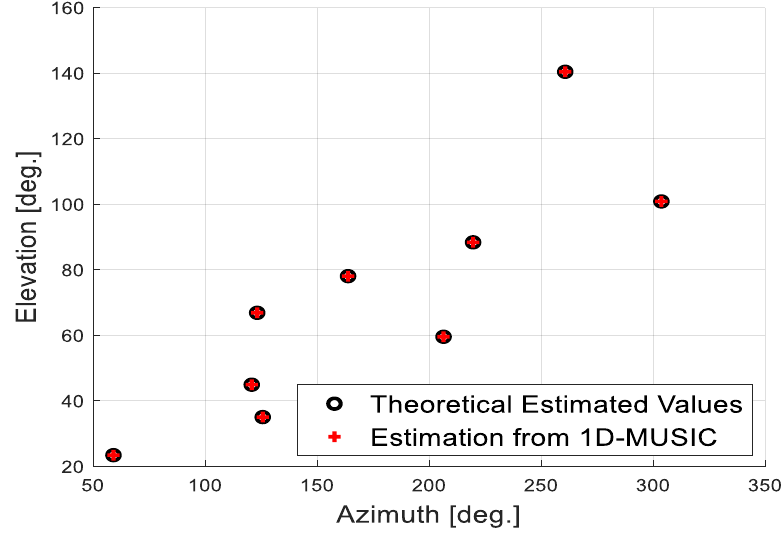
Figure 5. 1D-MUSIC harsh map.